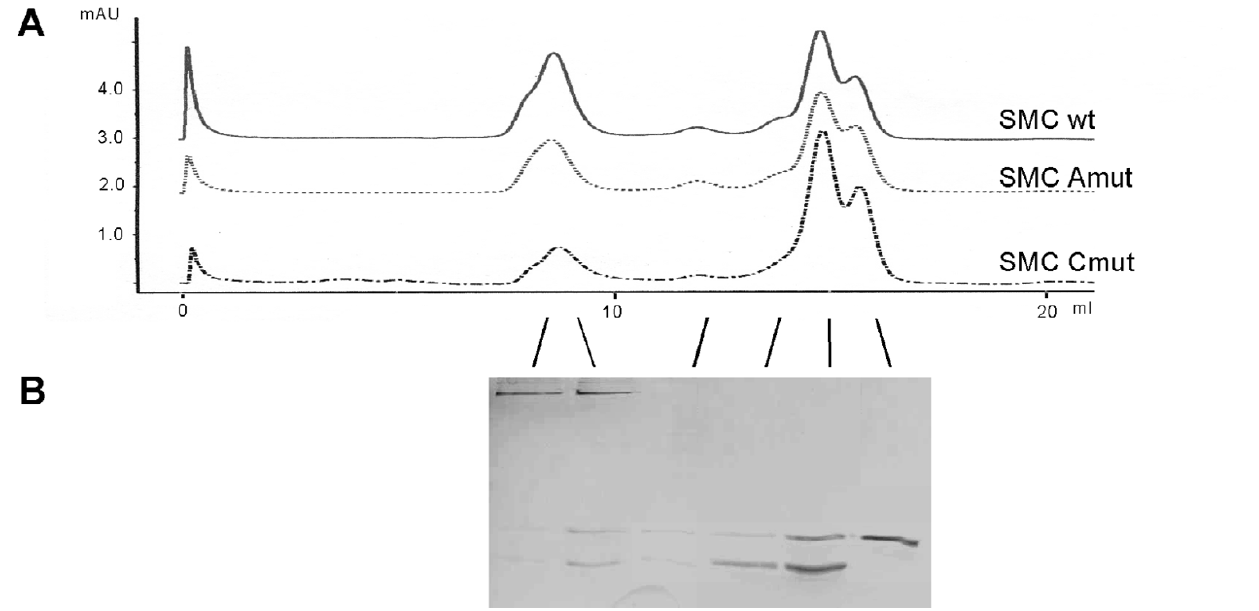
Figure 3 Analytical gel filtration assays with SMC and SMC mutant proteins. A) Comparison of gel filtration profiles of wild type SMC and SMC mutants (as noted on the profiles) incubated with ScpA and ScpB, same amounts as in Fig 1I). 1B) Silver stained SDS- PAGE with fractions loaded corresponding to elution peaks from gel filtration of SMC Walker A mutant incubated with ScpA and ScpB (corresponding to Fig.